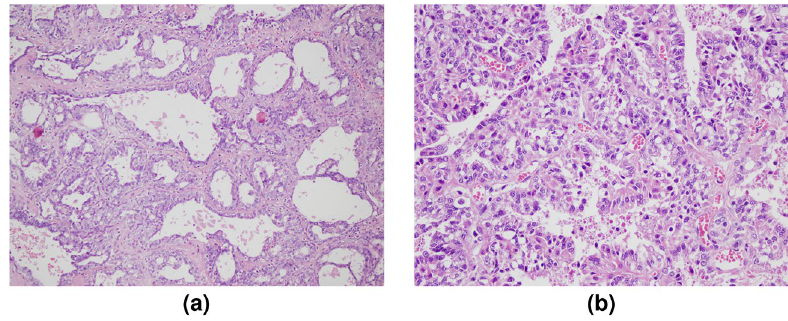
Figure 6. Histopathology picture of samples: ( a ) 10X200 view and ( b ) 15 × 400